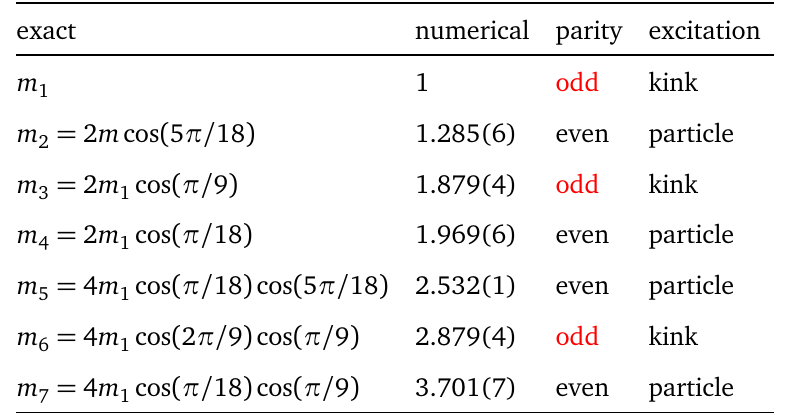
Table 4.1: Spectrum of the thermal deformation of the tricritical Ising